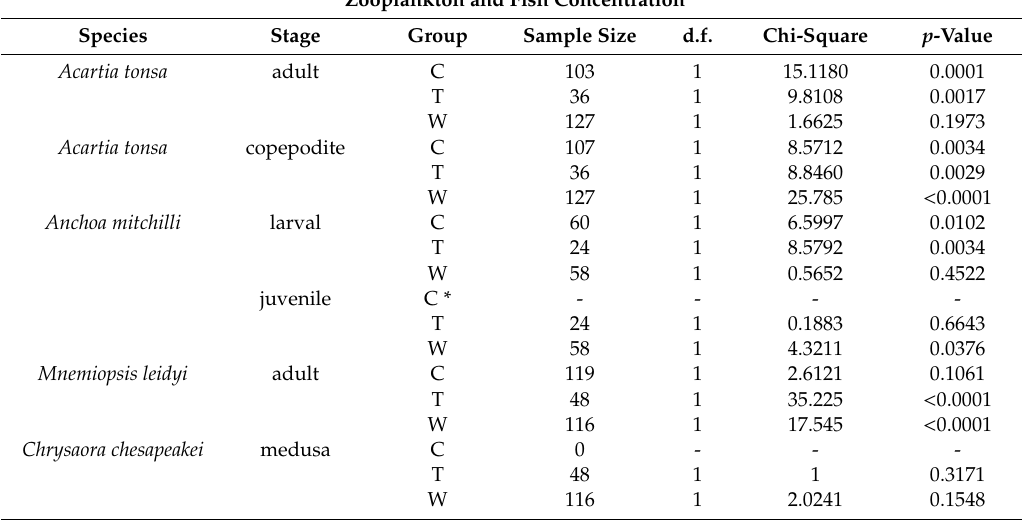
Figure 9. Comparison of copepod (Acartia tonsa) ( a ) adults and ( b ) copepodite concentrations between More-oxygenated (open bar) and Less-oxygenated (closed bar) subgroups within temperature groups (Cool, Temperate, Warm). Error bars indicate standard deviations and * indicates a significant difference in a Kruskal-Wallis test at α = 0.05.